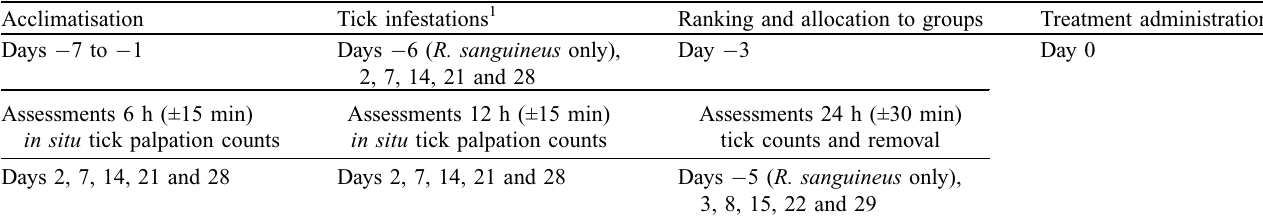
Table 1. Summary of the study schedule. Acclimatisation Tick infestations 1 Ranking and allocation to